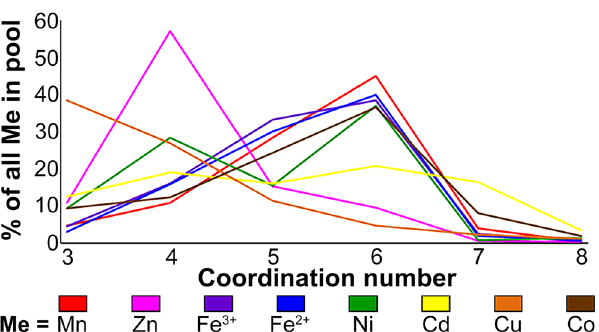
Figure 4. Main coordination number distribution of the different metals. For each metal, the percentage of each coordination number (CN, 3 to 8) is defined as the number of times the metal was bound in a specific CN divided by the total number of this metal in the statistics (in all coordination numbers, based on the data in Supplementary Table S2). Every metal is presented in different color: Manganese in red, zinc in pink, ferric in purple, ferrous in blue, nickel in green, cadmium in yellow, copper in orange and cobalt in brown.